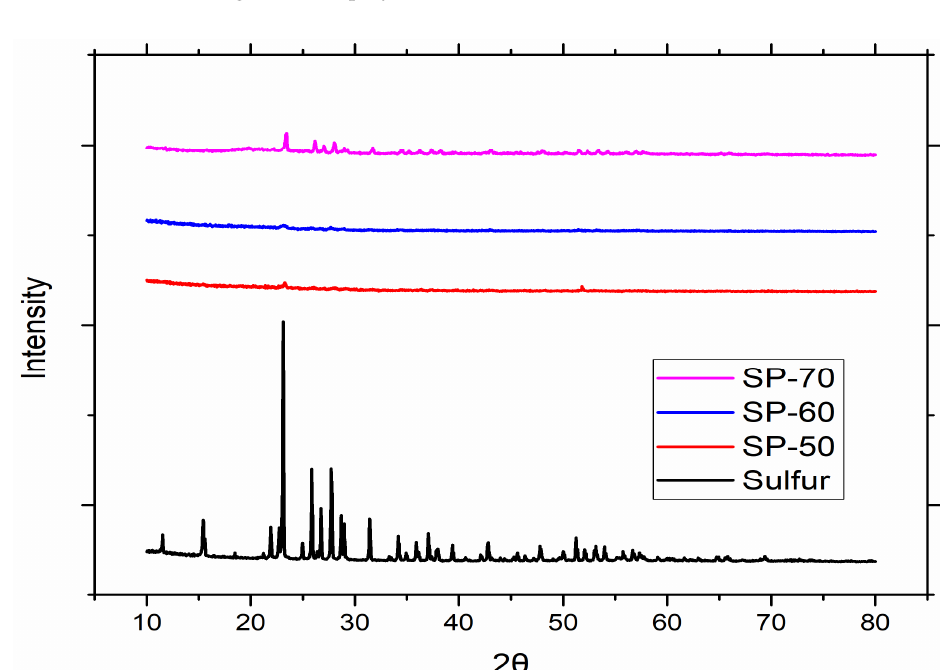
Figure 3. p-XRD diffractogram of all copolymer and elemental sulfur .